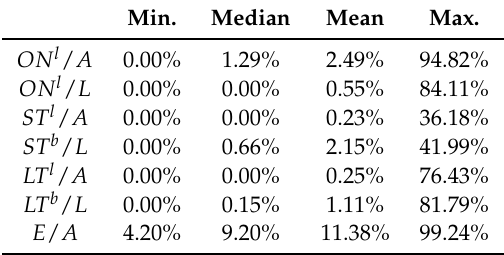
Table 4. Data summary of target ratios.